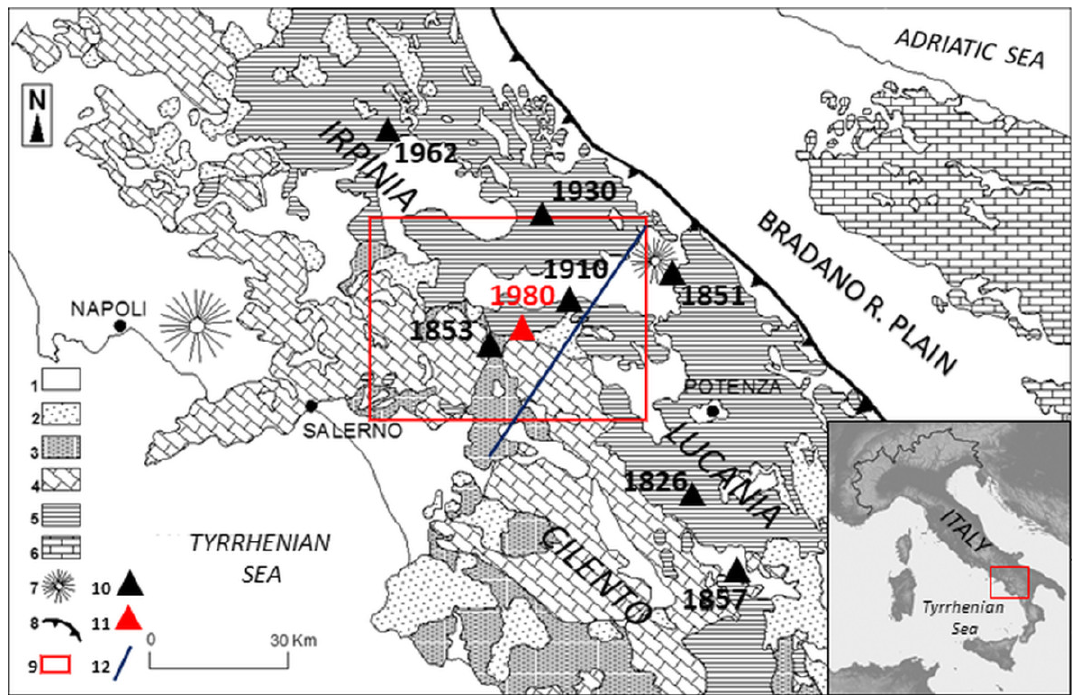
Figure 1. Geological sketch-map of the Southern Apennines (modified after [23]) and study area location (inlet). Legend: 1 . Quaternary and Pliocene deposits; 2 . Miocene deposits; 3. Liguride Complex; 4 . Apennine carbonate platform units; 5 . Molise-Lagonegro basin units; 6 . Apulian carbonate platform units; 7 . Volcanoes; 8 . orogenic front; 9 . study area; 10 . Historical earthquake epicenters [1,2]; 11 . 1980 earthquake epicenter [1,2]; 12 . Trace of geological sketch section in Figure 12b.